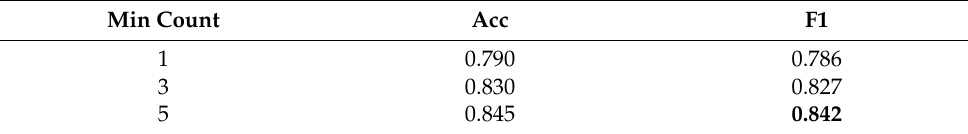
Table 14. Word2vec experiments.